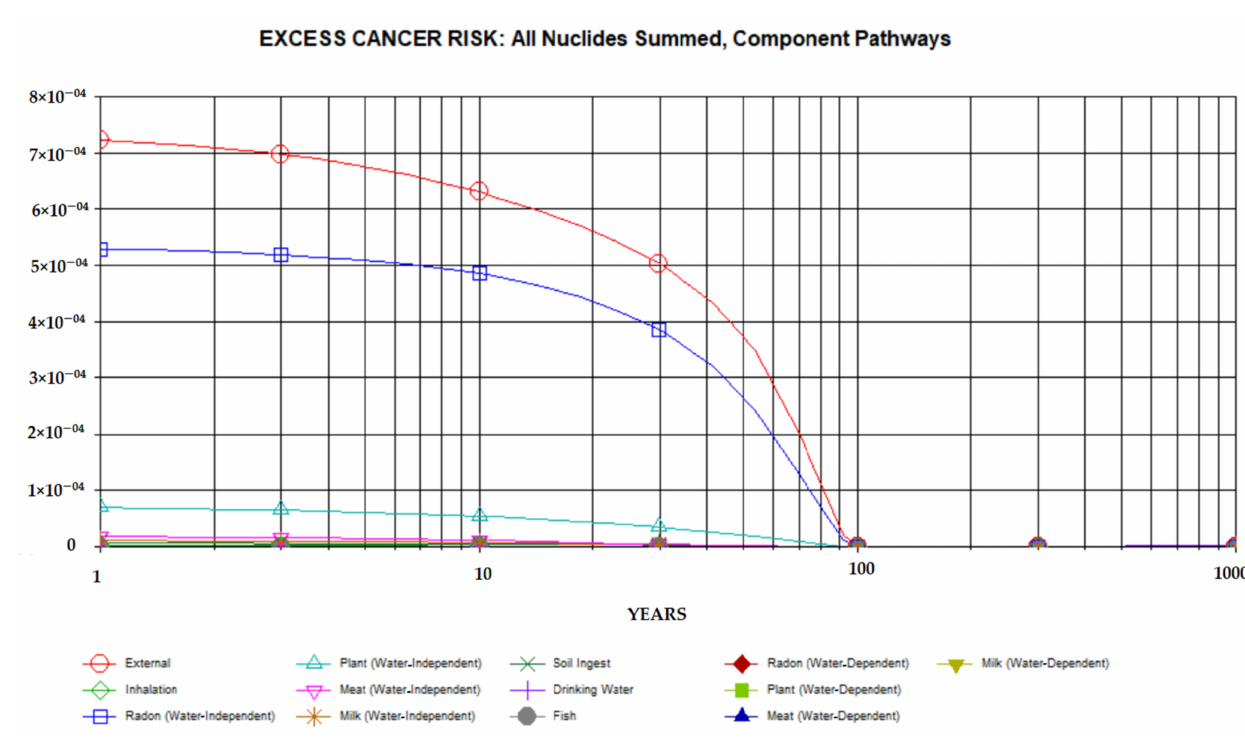
Figure 6. Contributions of exposure pathways to cancer risk.